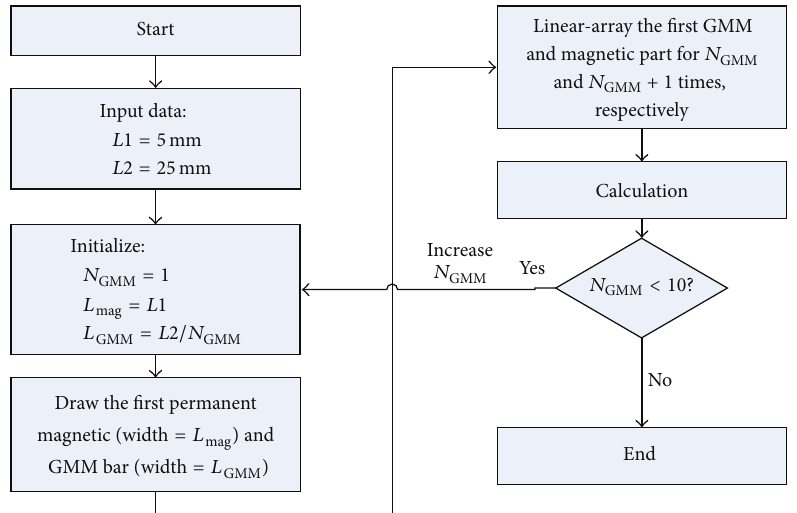
Figure 9: Flow chart for geometrical iteration of multi-GMM structure.